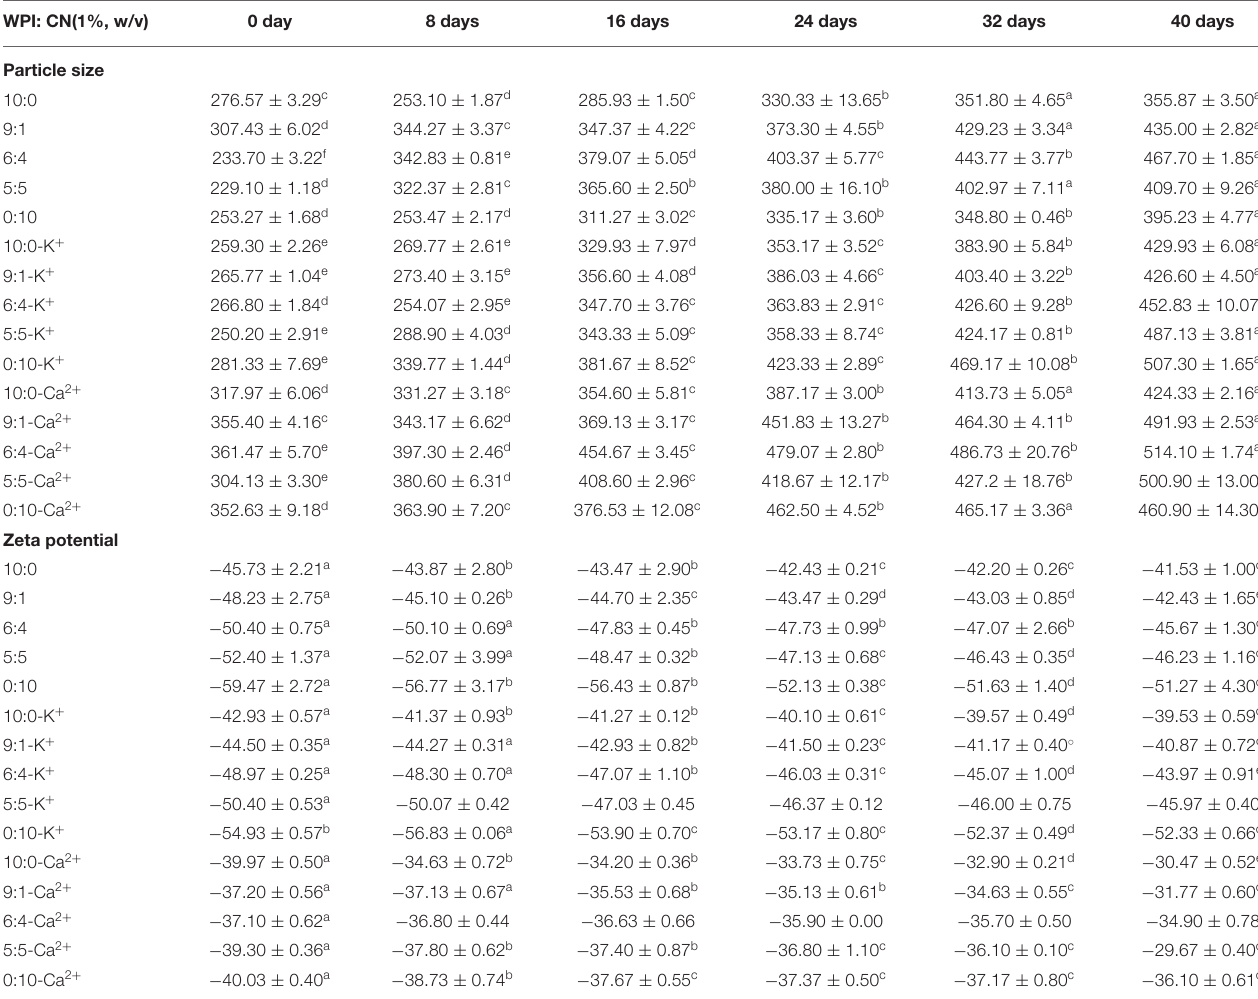
TABLE 2 | Effects of K + and Ca 2 + on storage stability (particle size and zeta potential) in different OPO emulsions (10% v/v OPO human milk fat substitutes and WPI: CN/10:0, 9:1, 6:4, 5:5, 0:10, 1% w/v in